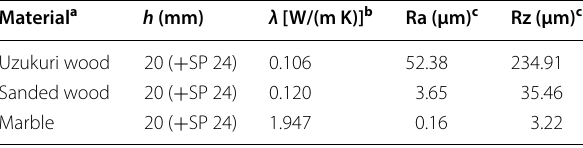
Table 1 Details of the